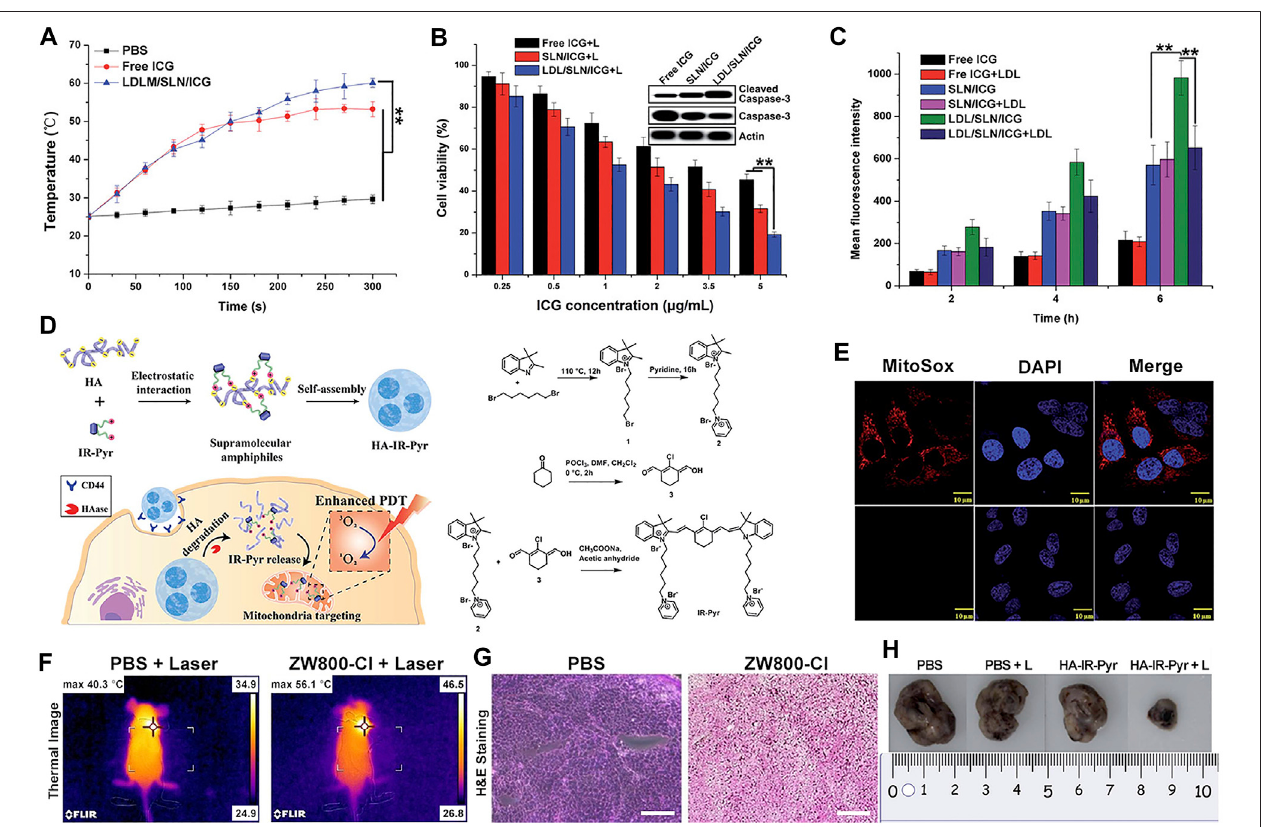
FIGURE 3 | Heptamethine cyanine – based application in tumor PTT and PDT. (A) . Photothermal conversion of LDL/SLN/ICG, and Free ICG. Reproduced with permission from (Pan et al., 2020). (B) . PTT induced the anticancer effect and mechanism of free ICG, SLN/ICG, and LDL/SLN/ICG on MCF-7 cells at different ICG concentrationsfor48 hunderirradiation.Reproducedwithpermissionfrom(Panetal.,2020). (C) .CellularaccumulationoffreeICG,SLN/ICG,andLDL/SLN/ICG(+LDL means pretreated withLDL) inMCF-7 cells detected byintracellularMFI. Reproduced with permission from (Pan et al.,2020). (D) . Schematic representation of the generationofmicellaraggregates(HA-IR-Pyr),accumulationinCD44overexpressingtumor,andtumormitochondrialocalizationtoenhancePDT.SynthesisrouteofIR- Pyr. Reproduced with permission from (Thomas et al., 2017). (E) . Comparison of singlet oxygen generation ability in HeLa cell lines after 3 min irradiation (upper). Comparison of singlet oxygen generation ability in HeLa cell lines without irradiation (lower). Reproduced with permission from (Thomas et al., 2017). (F) . Tumor volume rates of each group were monitored for 7 days. Reproduced with permission from (Lim et al., 2020). (G) . H and E stained section of tumor of each treatment group. Reproducedwithpermissionfrom(Limetal.,2020). (H) .Comparisonofthetumorsizeofeachtreatmentgroup(PBS,PBS+L,HA-IR-Pyr,HA-IR-Pyr+L)after16 days. Reproduced with permission from (Thomas et al.,